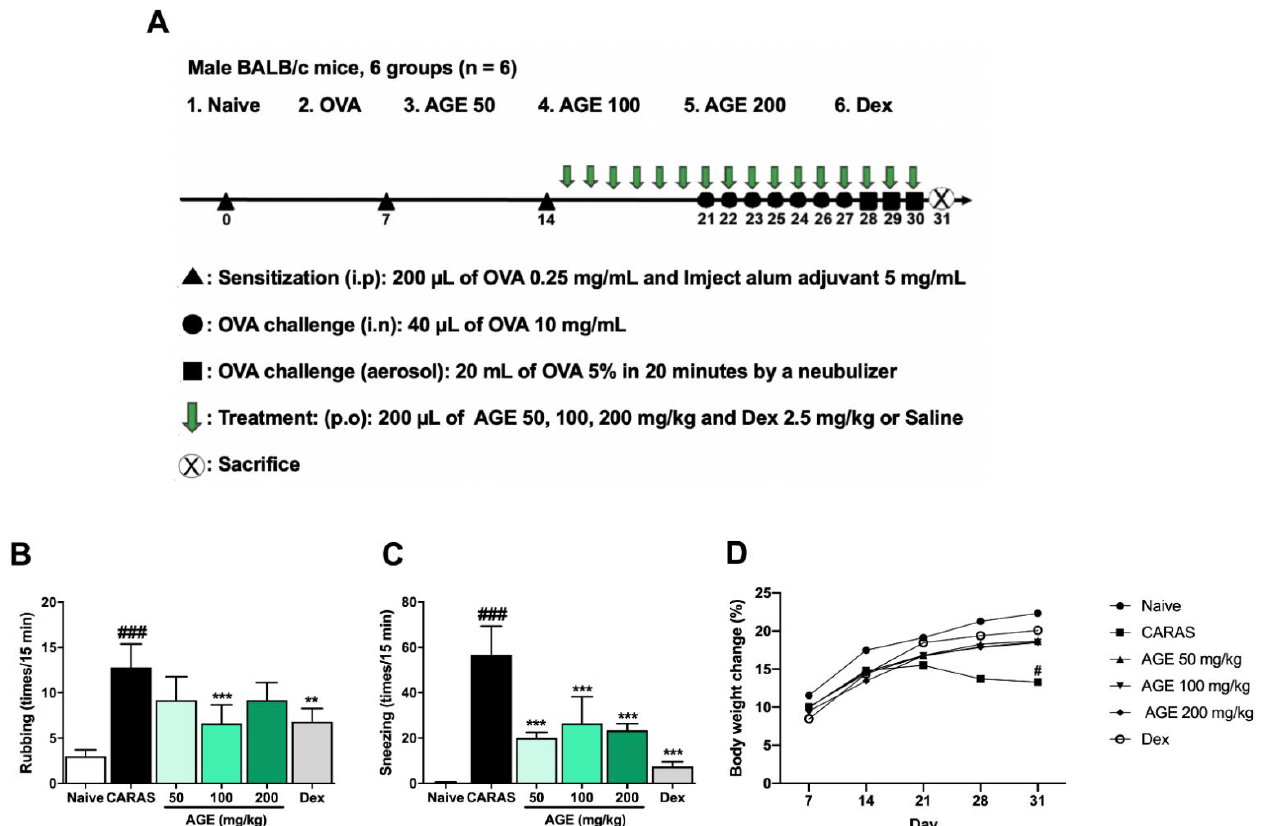
Figure 1. AGE inhibited the OVA-induced allergic symptoms in CARAS mice. ( A ) Animal protocol. ( B ) Rubbing. ( C ) Sneezing. ( D ) Body weight change. Mice were sensitized with OVA 3 times on days 0, 7, and 14 via intraperitoneal (i.p) injection. Mice were challenged with OVA from day 21 to day 27 by intranasal (i.n) and then from day 28 to day 30 by aerosol exposure to OVA. Mice were treated with AGE 50, 100, 200 mg/kg, or Dex 2.5 mg/kg orally (p.o) once daily from day 15 to day 30. The mice in the naive group were not sensitized, challenged, or treated. The mice in the CARAS group were treated with saline. Oral administration of AGE 50, 100, 200, or Dex 2.5 mg/kg significantly decreased the sneezing times in CARAS mice on day 27. At a dose of 100 mg/kg, AGE notably reduced the rubbing times in CARAS mice as well. All results are shown as the mean ± SD (n = 6 per group). # Compared to naive, * compared to CARAS. ### , *** p < 0.001; ** p < 0.01. CARAS = combined allergic rhinitis and asthma syndrome; AGE = Artemisia gmelinii extracts; Dex = dexamethasone; OVA = ovalbumin.